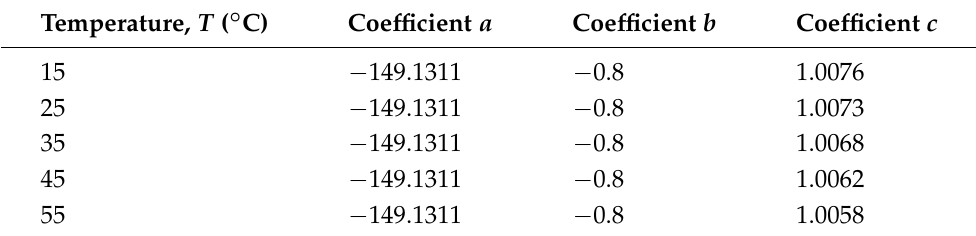
Table 5. Coefficients with different temperature and on left side operation.